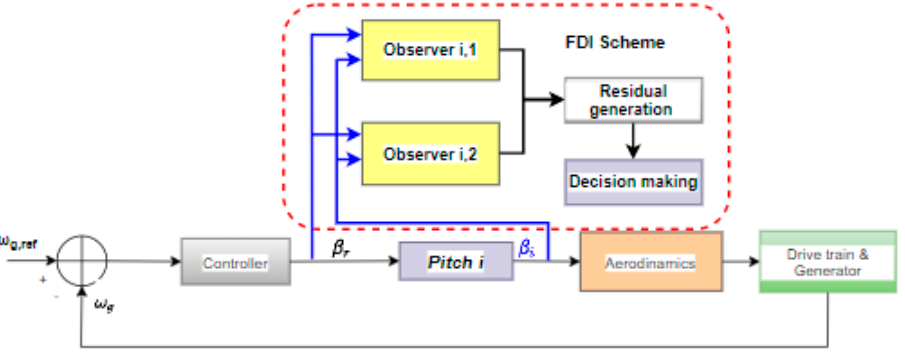
Figure 3. Architecture for FDI in the pitch system.